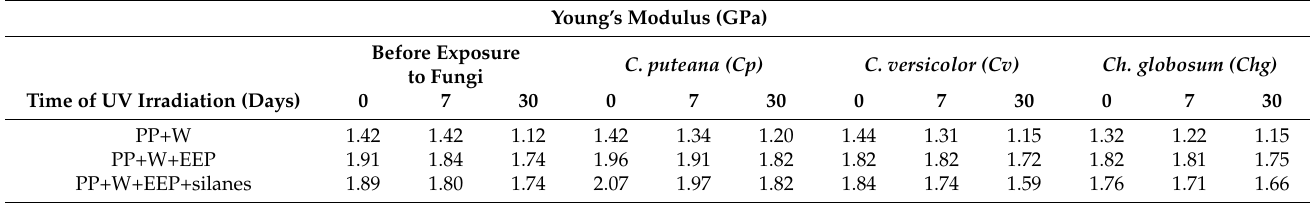
Table 3. Young’s modulus of WPCs. Young’s Modulus